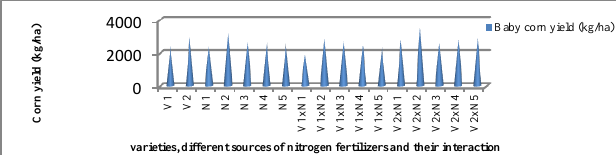
Figure 2: Effect of varieties, different sources of nitrogen fertilizers and their interaction on corn yield (kg/ha) of baby corn (V 1 = BARI sweet corn-1, V 2 = Baby star, N 1 = (100% urea – N), N 2 = (75% urea – N + 25% CD – N), N3= (50% urea – N + 50% CD – N), N 4 = (75% urea